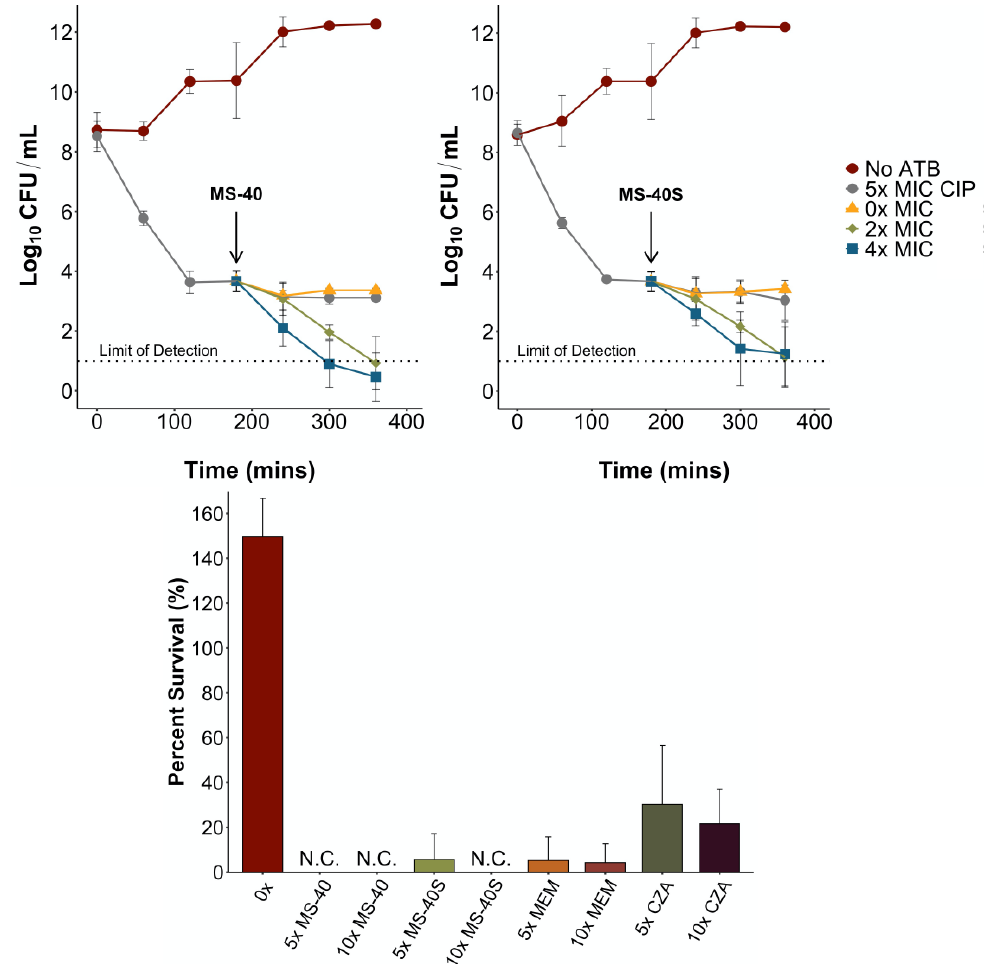
Figure 4. MS-40S kills and inhibits the formation of persister cells. ( Top ) An exponential phase culture with approximately 1 × 10 8 CFU/mL was exposed to 5× MIC ciprofloxacin (CIP) to generate persister cells. At three hours post-exposure, persister cells were washed, resuspended in PBS and exposed to 0×, 2×, or 4× MIC of MS-40 ( top left ) and MS-40S ( top right ) for an additional three hours. No ATB; no antibiotic. ( Bottom ) An overnight culture of B. cenocepacia K56-2 was incubated with the corresponding antimicrobial, MS-40, MS-40S, meropenem (MEM), or ceftazidime–avibactam (CZA). Percent survival was calculated by the log 10 CFU/mL of the surviving population/log 10 CFU/mL of the initial population. N.C., no colonies.